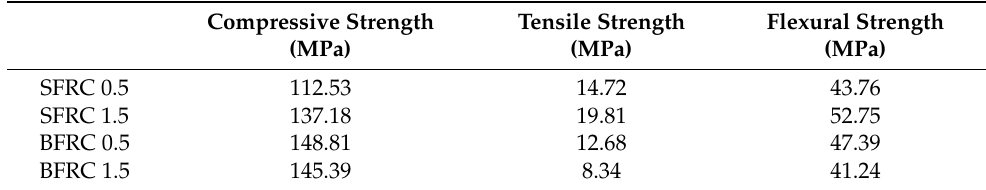
Table 3. Mechanical performance of basalt/steel fiber reinforced concrete, adopted from [15].